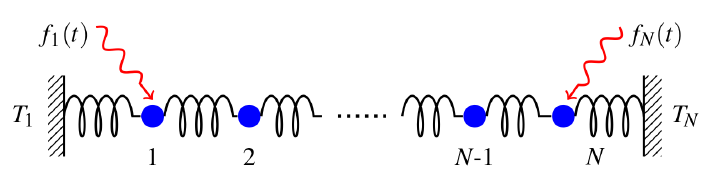
Figure 1: Schematic representation of a chain of oscillators connected to two nonequilibrium reservoirs which exert active forces f